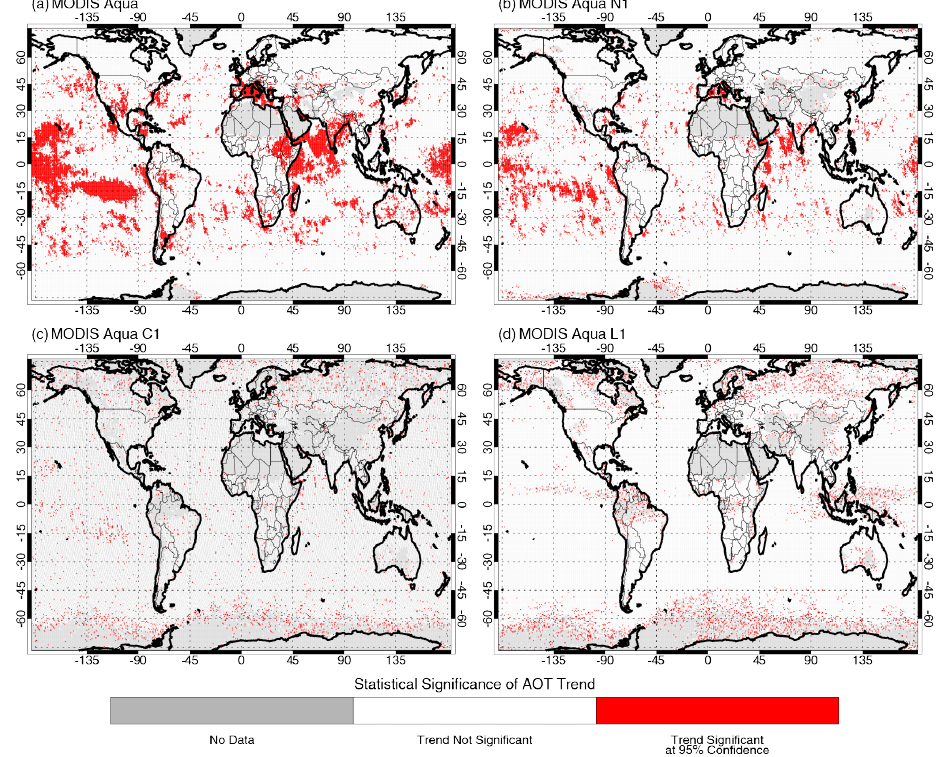
Figure 12. As in Fig. 11, but showing the statistical significance for the trends shown in Fig. 11. Regions colored red show regions with statistically significant trends at the 95% confidence